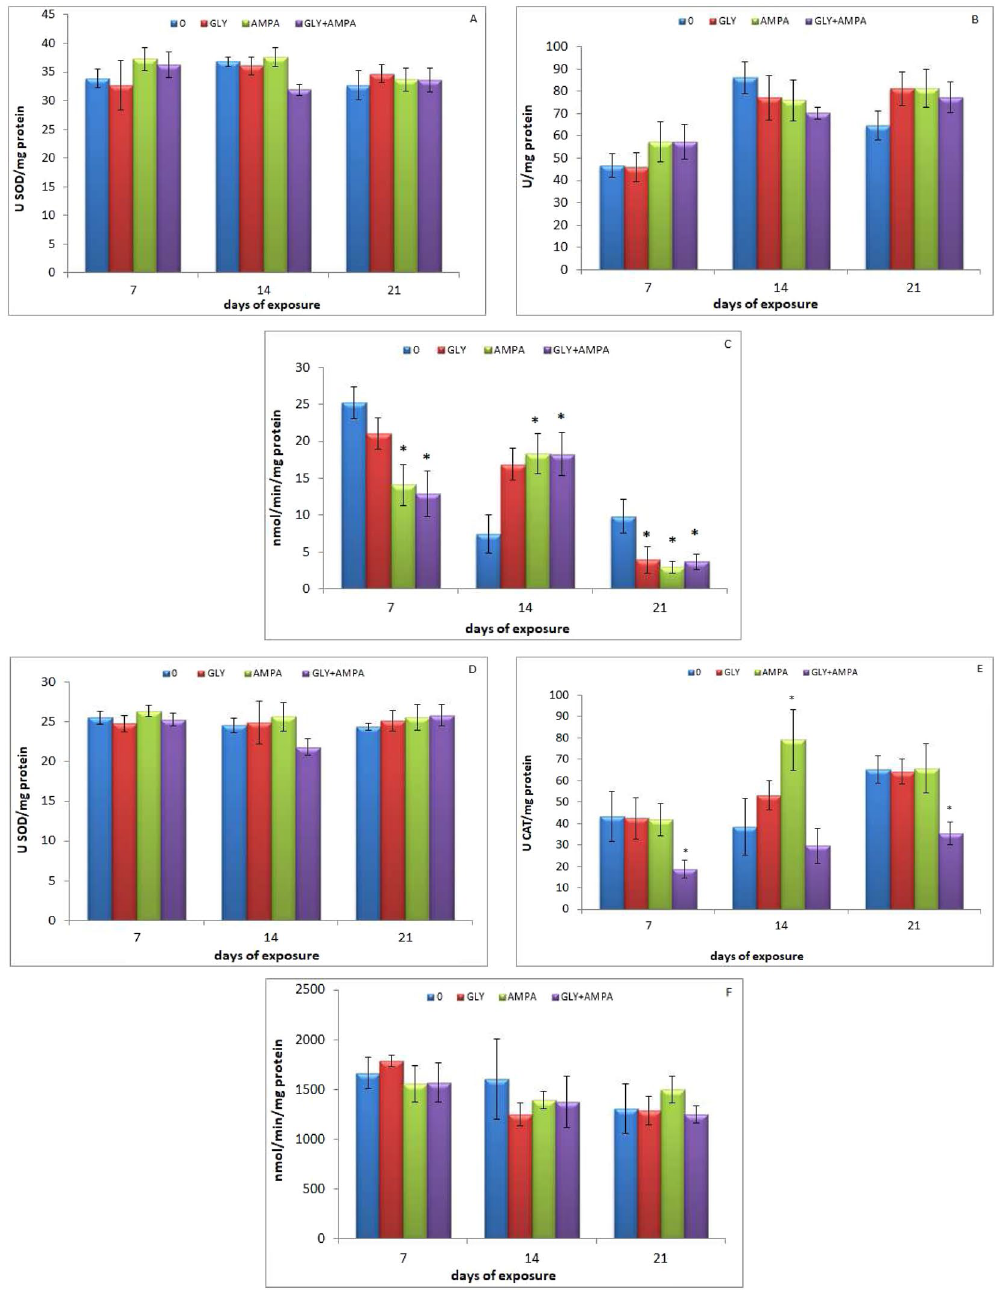
Figure 2. SOD and CAT activities, expressed as U/mg protein, and AChE activity, expressed as nmol/min/ mg protein in gills ( A – C ), SOD and CAT activities, expressed as U/mg protein, and GST activity, expressed as nmol/min/mg protein in digestive gland ( D – F ) of M . galloprovincialis exposed to glyphosate (GLY), AMPA and GLY + AMPA. The values are mean + SD (n = 5). The asterisks indicate significant differences in comparison with controls: * p <